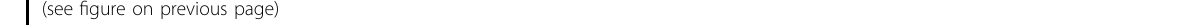
Fig. 1 Optimized barcoding strategy and construction of the CAPTURE library. a Diagram of the optimized barcoding backbone and how the barcodes were targeted. When Cas9 nickase and a pair of gRNAs that target a corresponding barcode are delivered, ~2/3 of the targeted barcode will lead to frameshift and silencing of eGFP. b Schematic illustration of the CAPTURE work fl ow. Barcoded cells will be eGFP and RFP double positive. Founder-barcoded cells are then expanded and divided into control and treatment groups. After phenotypic clonal evolution, lineages of interest are determined by next-generation sequencing (NGS) of barcode distribution. Meanwhile, cryogenic stocks of the cell populations are made to isolate lineages of interest. By delivering paired gRNAs, which target the corresponding barcodes, to the cell populations one at a time, lineages of interest can be isolated by FACS. c Ef fi ciency of fl uorescence switching of BC1-barcoded cells with various percentages in the pool. The numerical values for each gated population are in percent, and the total numbers of cells analyzed for each experiment were 12,562, 24,078, 20,959, 18,131, 24,185, and 24,196, respectively. d The purity of isolated cells is determined by NGS. The percentages of sorted cells from c and 100% BC2 groups that were targeted by corresponding gRNAs. e Nucleotide position distribution, modi fi ed from CRISPResso2 analysis, showing editing outcomes of BC1 targeting. f Approach to achieve high-complexity (36 million barcodes) CAPTURE library using ~12,000 oligonucleotides. g Plot of barcode distribution and cumulative barcode percentage. The barcode distribution in the library is plotted in blue. The cumulative distribution of the unique barcodes is shown in red. h Microscopic view of the cells barcoded by CAPTURE. Scale bar, 50